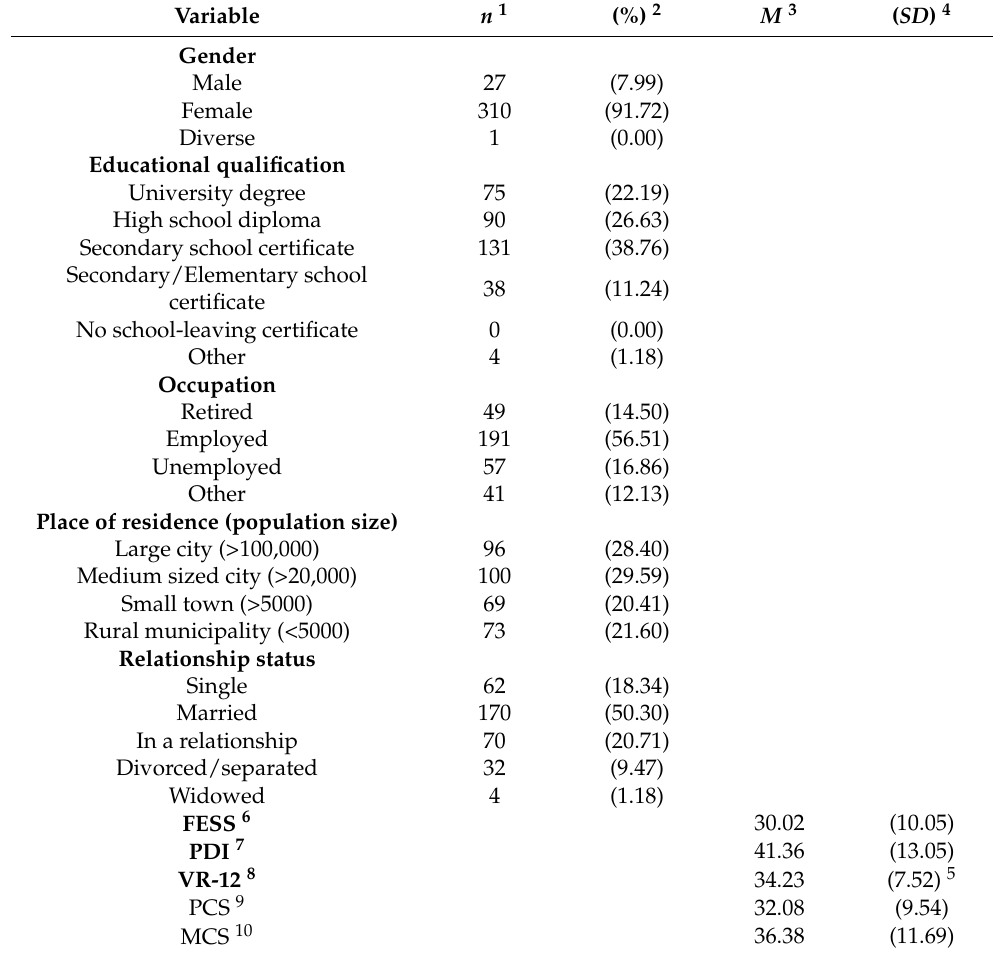
Table 1. Sociodemographic and psychometric data of